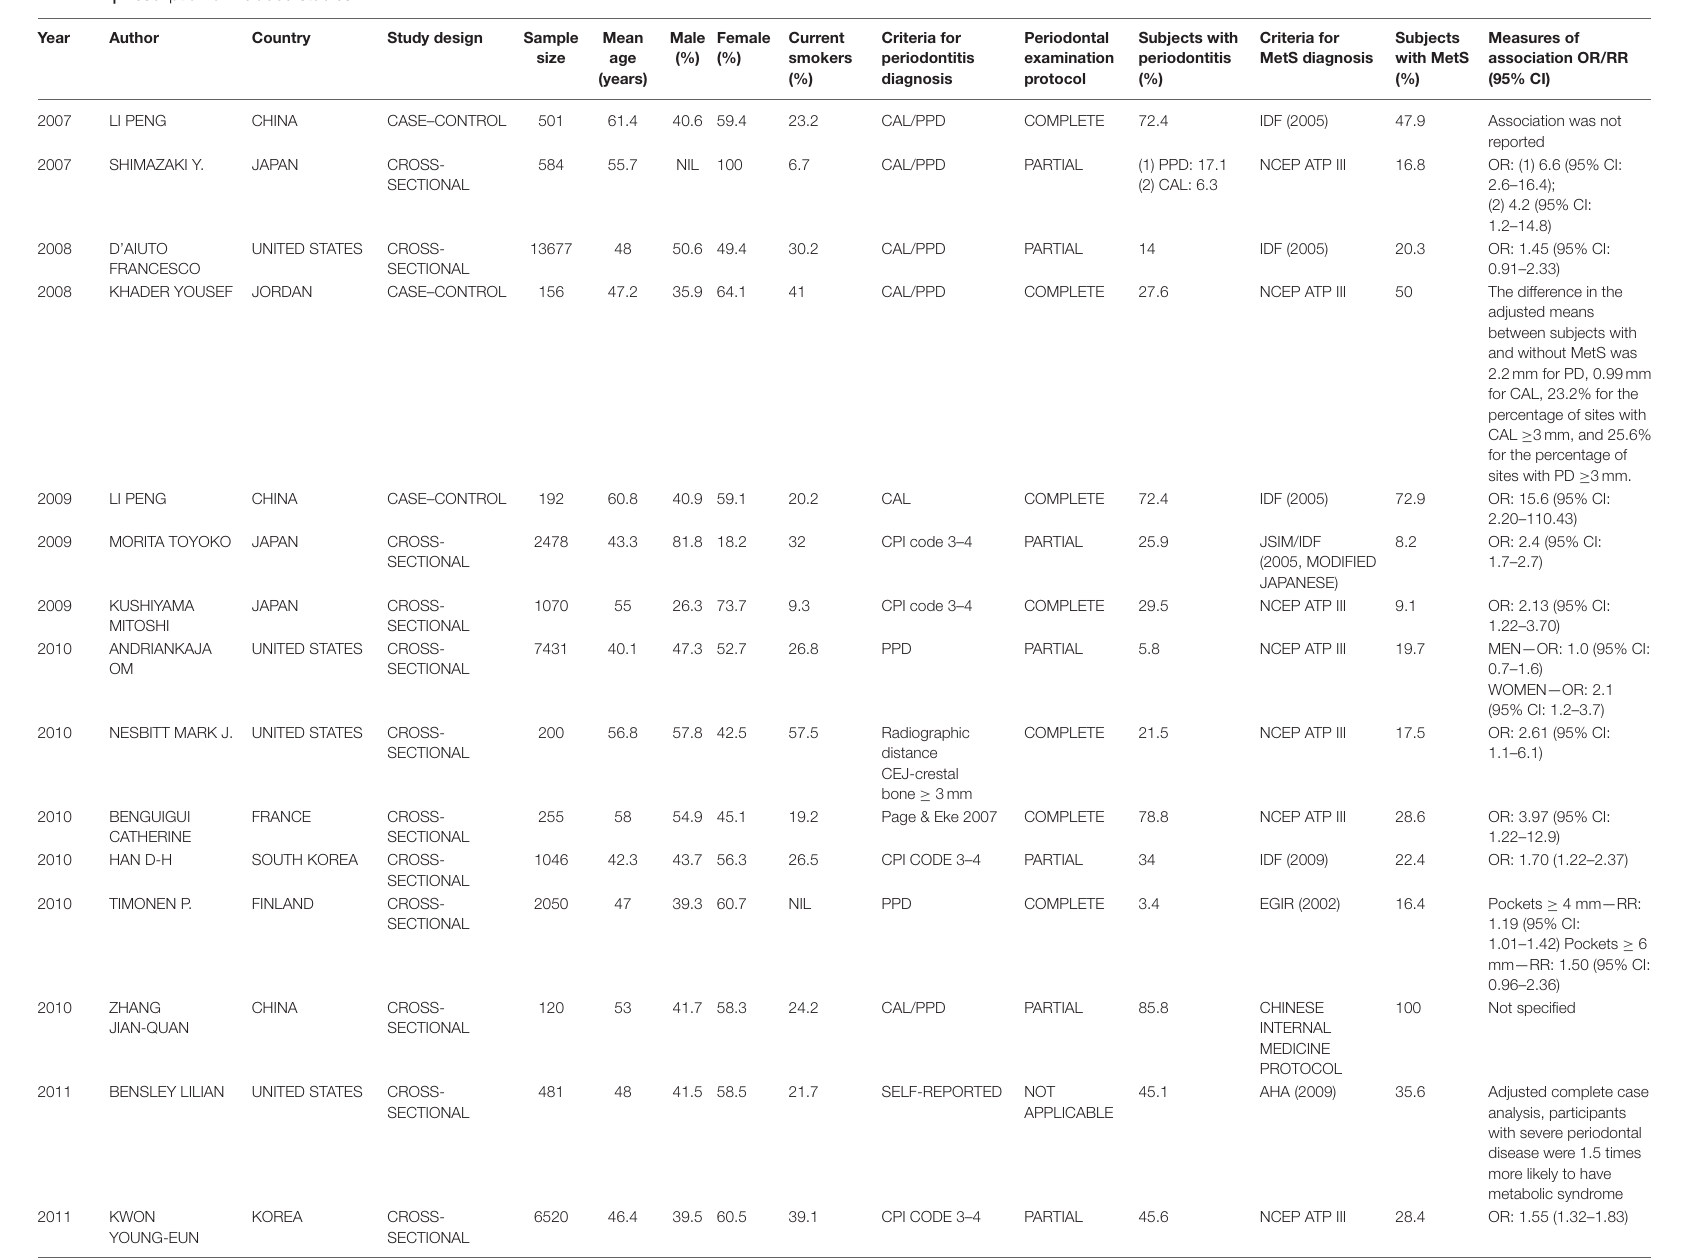
TABLE 1 | Description of included studies.